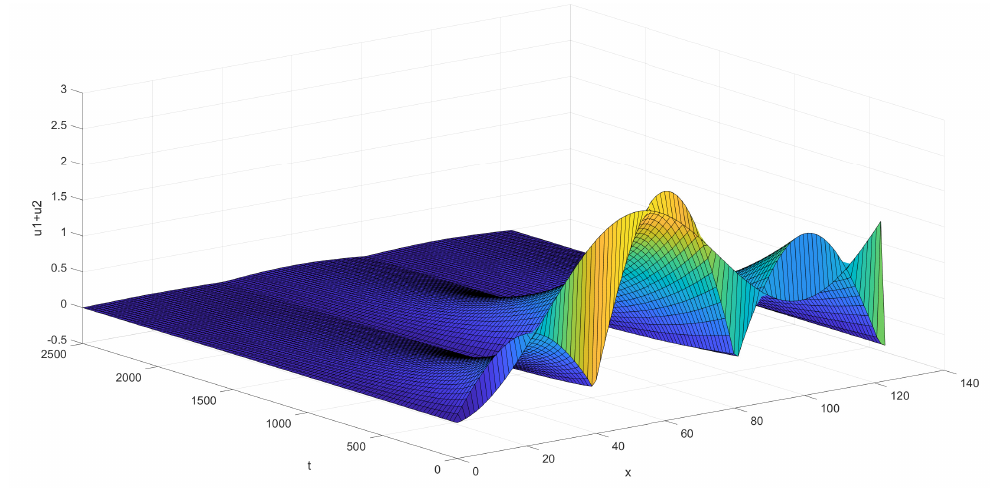
Figure 5. Decay of ticks in the case of three pairs of background/control zones.